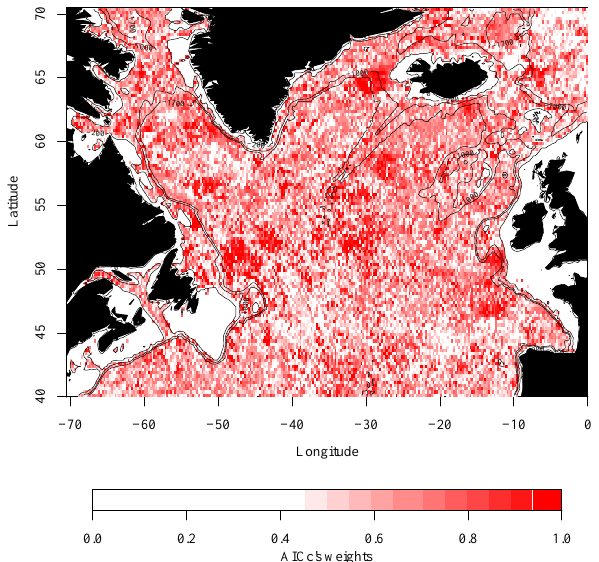
Figure A1. Akaike weights of the selected model for each 0 . 25 ◦ pixel, as in Fig. 3 in the main text. Only pixels where the weight of the winner model is higher than 30% and the bottom depth exceeds 200m are used in this